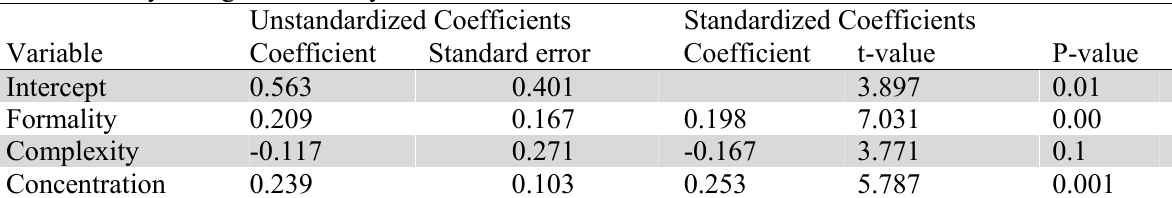
The summary of regression